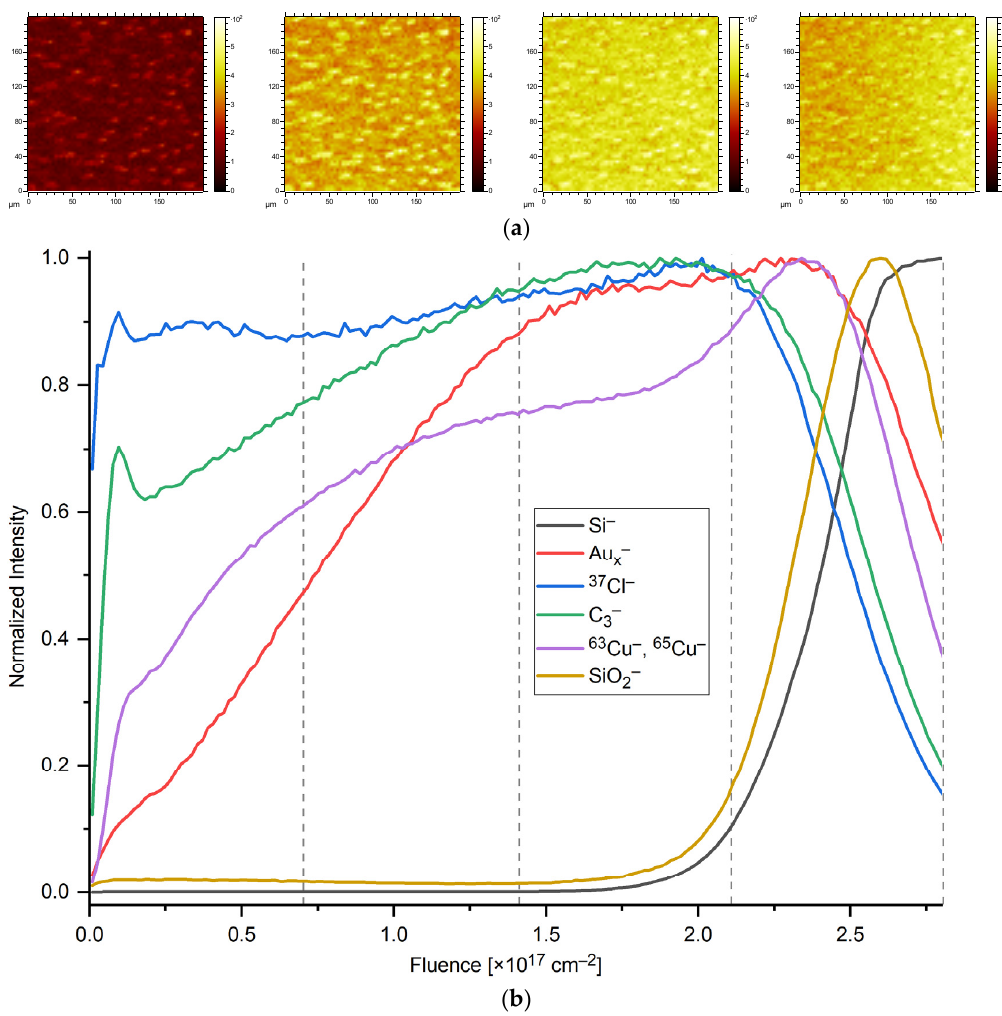
Figure 4. Time-of-flight secondary ion mass spectrometry (ToF-SIMS) depth profiling. ( a ) Lateral distribution of gold (sum of Au x − signals, x = 1 . . . 5) from each quarter of the analytical run (dashed grey lines) corresponding to the top to bottom of the layer, left to right). ( b ) Signal intensities of silicon (black line), SiO 2 (yellow line) the sum of both copper isotopes (violet line), 37 Cl − (blue line), C 3 − (green line), and the sum of Au x − species (x = 1 . . . 5) (red line) plotted against sputter ion fluence as an arbitrary measure for depth. All signals are scaled to 1 for their respective maximum